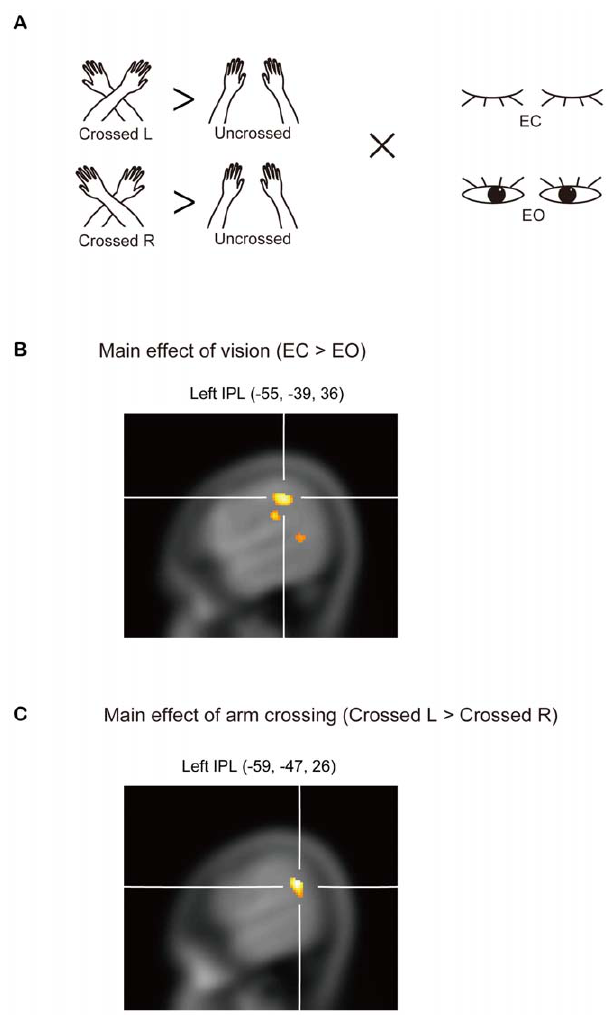
Figure 2. Experimental conditions and ANOVA data from the functional imaging. ( A ) Experimental conditions. Each participant experienced three arm positions: left over right arm (Crossed L), right over left arm (Crossed R) and arms uncrossed (Uncrossed). The participants’ eyes were either closed (EC) or open (EO). Each participant therefore experienced a total of six conditions, with the order of presentation counterbalanced across participants. ( B ) The left inferior parietal lobule region that showed significant main effect under (EC or EO) conditions [( 2 55, 2 39, 36); P , 0.05, uncorrected, masked by [(EC Crossed 2 EC Uncrossed) 2 (EO Crossed 2 EO Uncrossed) contrast at P =0.05]. ( C ) The left inferior parietal lobule region that shared a significant main effect under (Crossed L or Crossed R) conditions [( 2 59, 2 47, 26); P , 0.05, uncorrected masked by [(Crossed L 2 Uncrossed) 2 (- Crossed R 2 Uncrossed) contrast at P